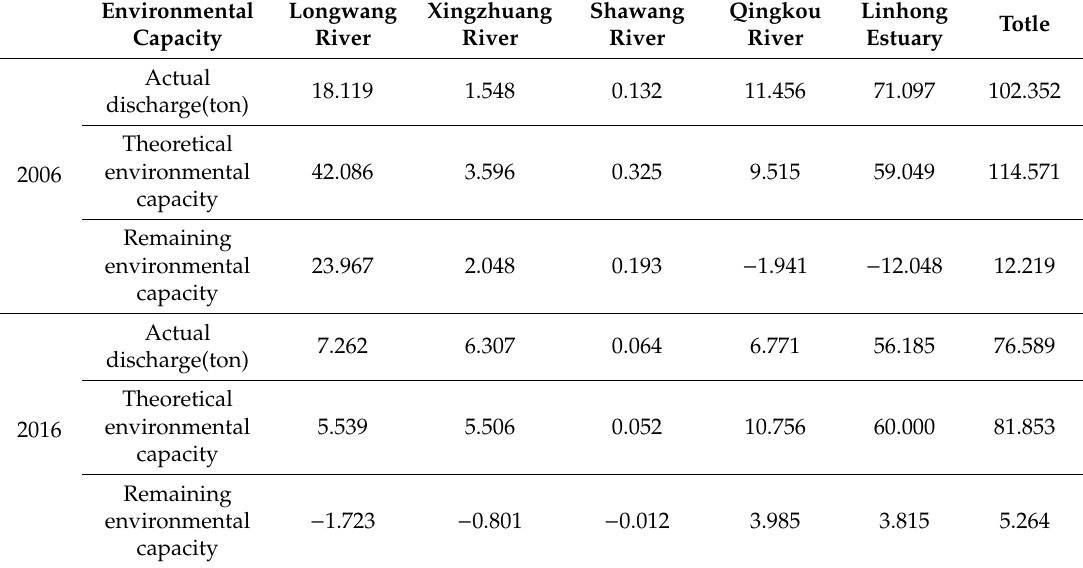
Table 5. The marine environmental capacity of COD in 2006 and